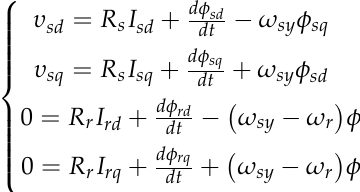
Figure 12. PI-controlled pitch